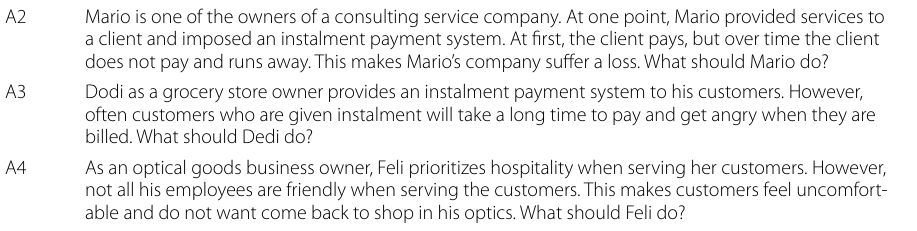
Table 5 Correlation coefficient between dimensions of entrepreneurial competences (current and previous scale), dimensions of risks, and business success